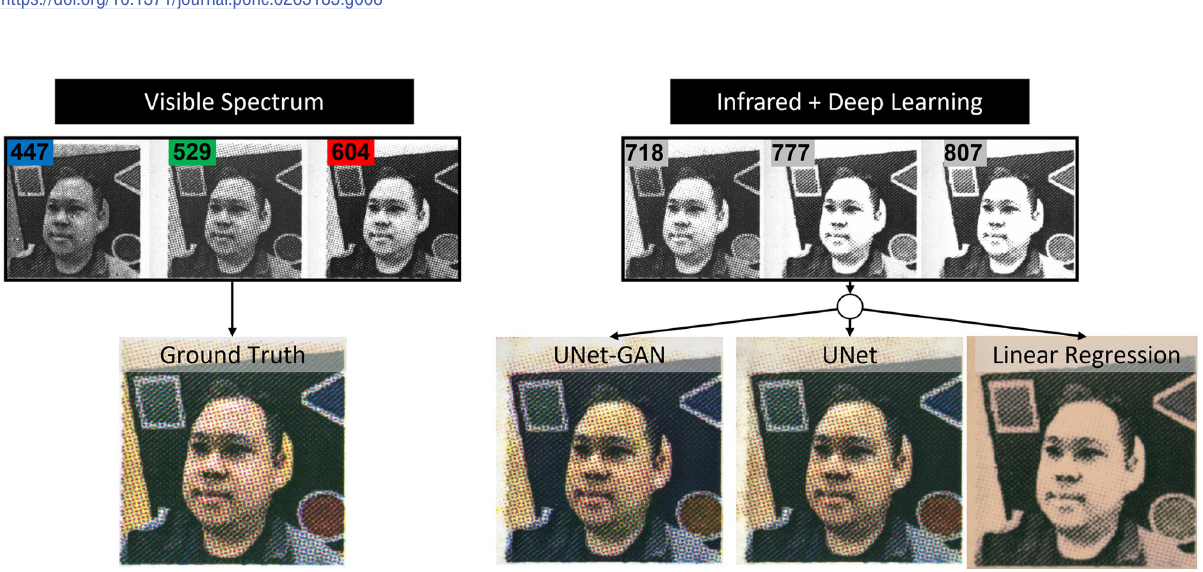
Fig 9. Visualization of the reconstructed RGB images by the deep architectures and baseline regression model. ( left ) Visible spectrum ground truth image composed of red, green and blue input images. ( right ) Predicted reconstructions for UNet-GAN, UNet and linear regression using 3 infrared input